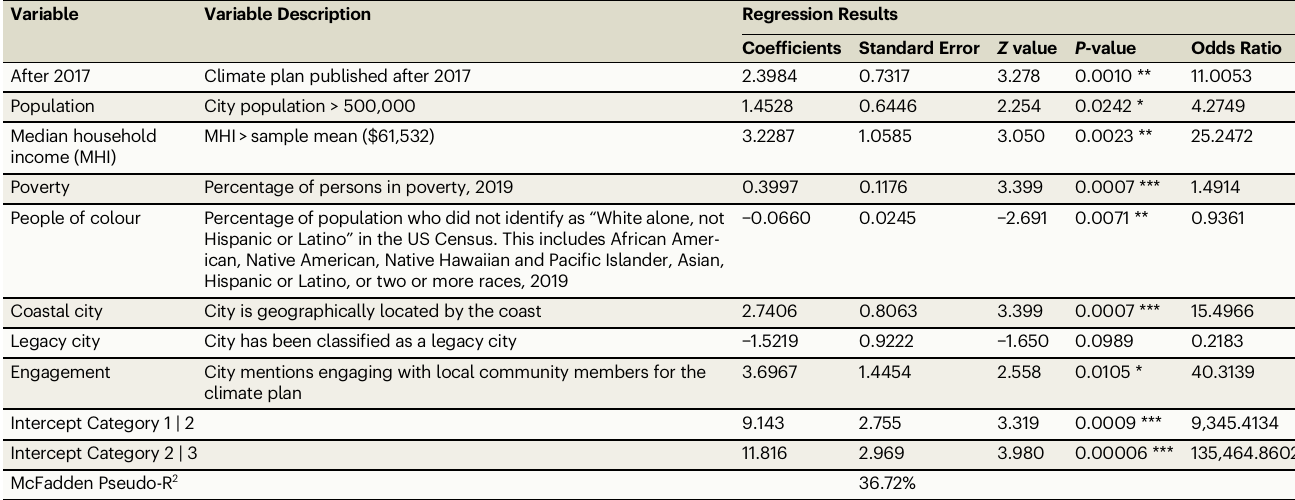
Table 2 | Local factors and climate plan characteristics and their effect on cities ’ level of engagement with justice in climate action planning